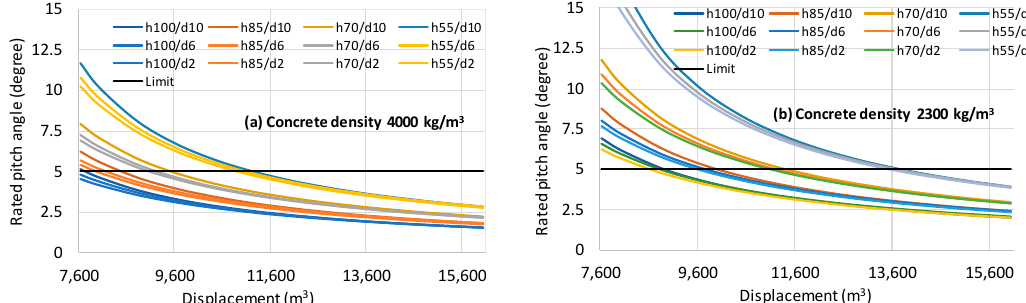
Figure 7. Relation between mean pitch angle at rated thrust force for the spar-type platform with a moonpool wind turbine with differences in displacement, draft and moonpool diameter of the platform.